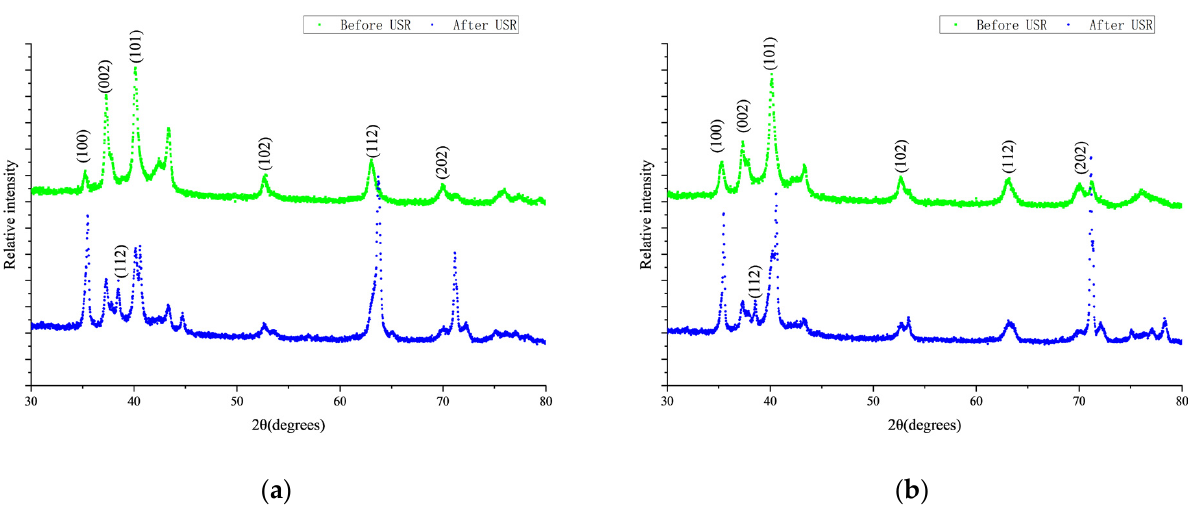
Figure 13. XRD diffraction patterns before and after ultrasonic treatment: ( a ) 1#; ( b ) 2#. Comparing the XRD patterns of A and B blocks before and after treatment, it was found that the main diffraction peak value and the width of each derivative peak changed.